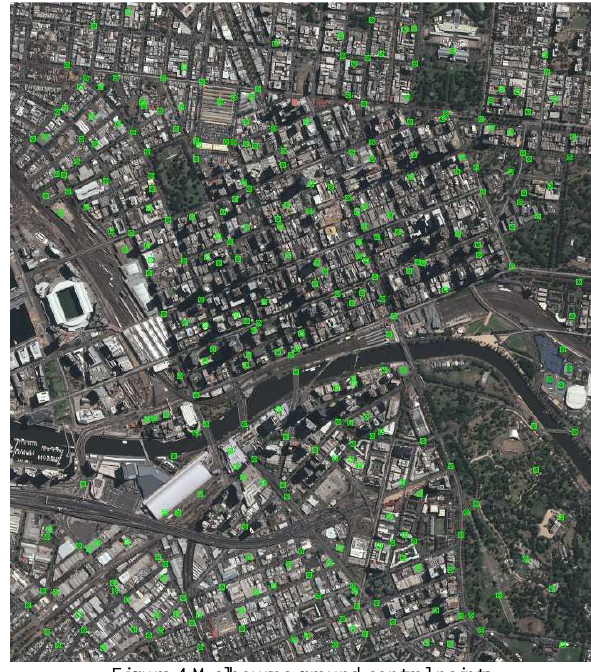
Figure 4 Melbourne ground control points